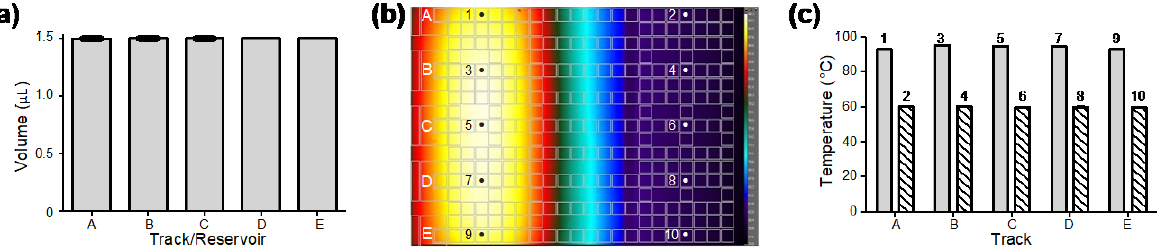
Figure 2. Performance tests of droplet volume consistency and temperature uniformity of the DMF cartridge. ( a ) Consistent volume of droplets generated on different droplet tracks from their corresponding reservoirs ( n = 3 for each track/reservoir). ( b ) Infrared thermal imaging of a DMF cartridge filled with hexadecane providing uniform temperature distribution in two temperature zones for qPCR amplification. ( c ) Direct thermocouple measurements of hexadecane at locations 1–10 shown in ( b ) cross droplet tracks in 95 °C and 60 °C temperature zones ( n = 3 for each location).